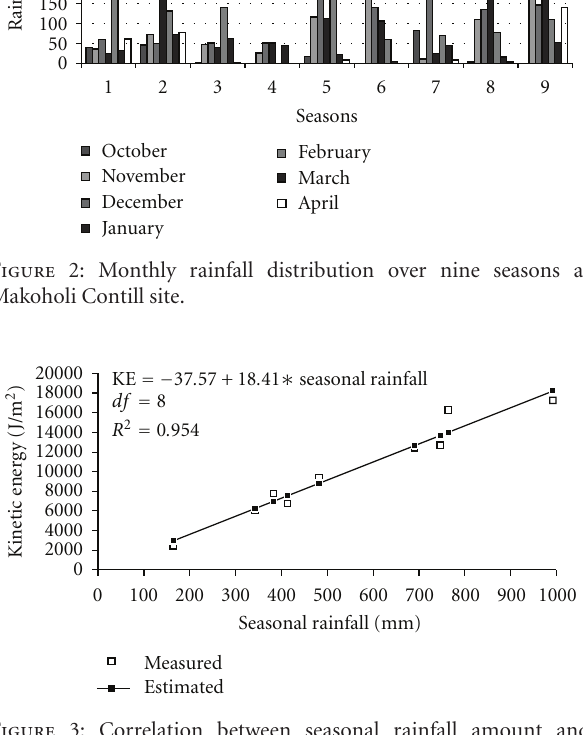
Figure 3: Correlation between seasonal rainfall amount and seasonal rainfall energy during nine seasons at Makoholi Contill site.